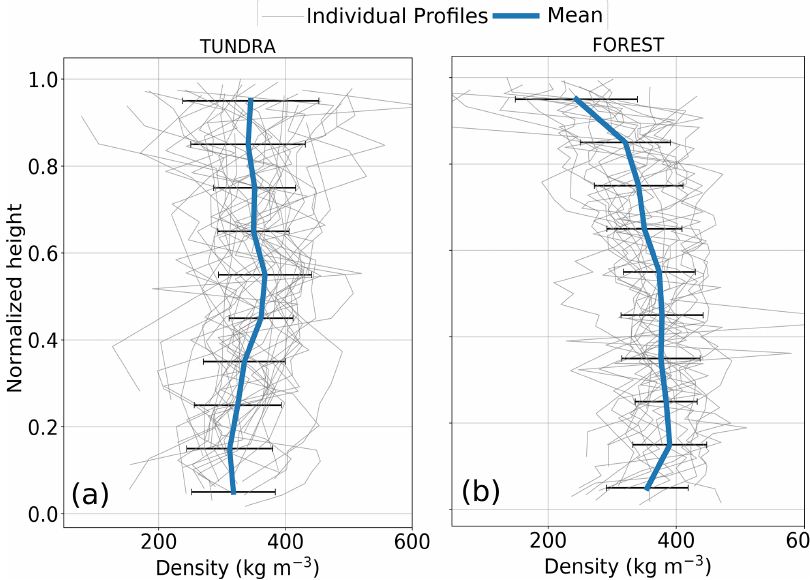
Figure 6. Snow density profiles from 29 snow pits near TUNDRA and 18 snow pits near FOREST collected between January and March from the years 2012 to 2019. For better comparability, snow heights were normalized. The mean of all profiles is also shown, together with the standard deviation.